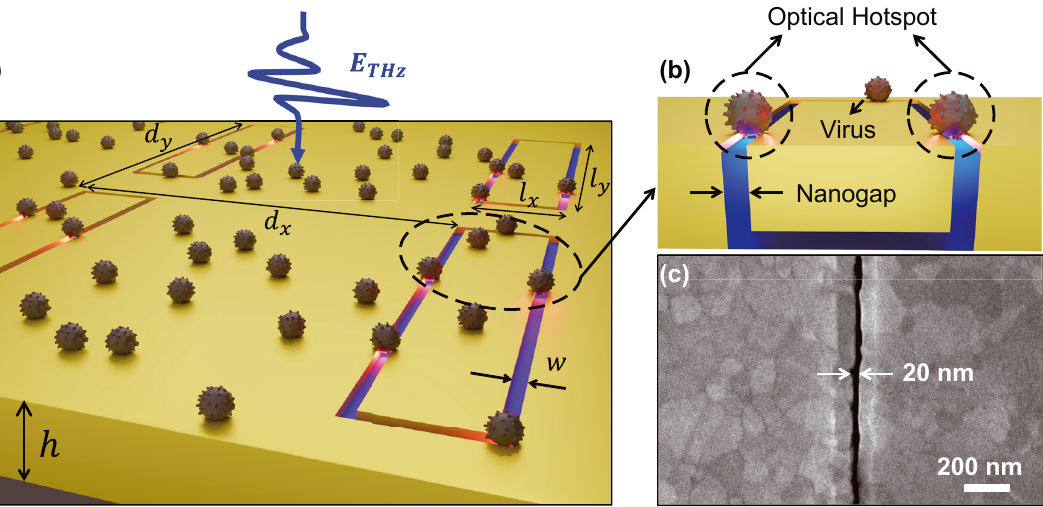
Figure 1: Terahertz virus-sized gold nanogap. (a) Schematic of the gold nanogap-loop array ( l x = 10 μ m, l y = 40 μ m, d x = 100 μ m, d y = 50 μ m, and h = 100 nm) coated with PRD1 viruses. The electric field polarization of the terahertz wave is perpendicular to the long axis of each loop. (b) Enlarged view of the PRD1 virus particle onto the etched gap with a width ( w ) of 20 nm. Strong near-field confinement in the vicinity of nanogaps called an optical hotspot facilitates the sensitive detection of gap-sized PRD1 viruses. (c) Top-view scanning electron microscope (SEM) image of a 20 nm gold